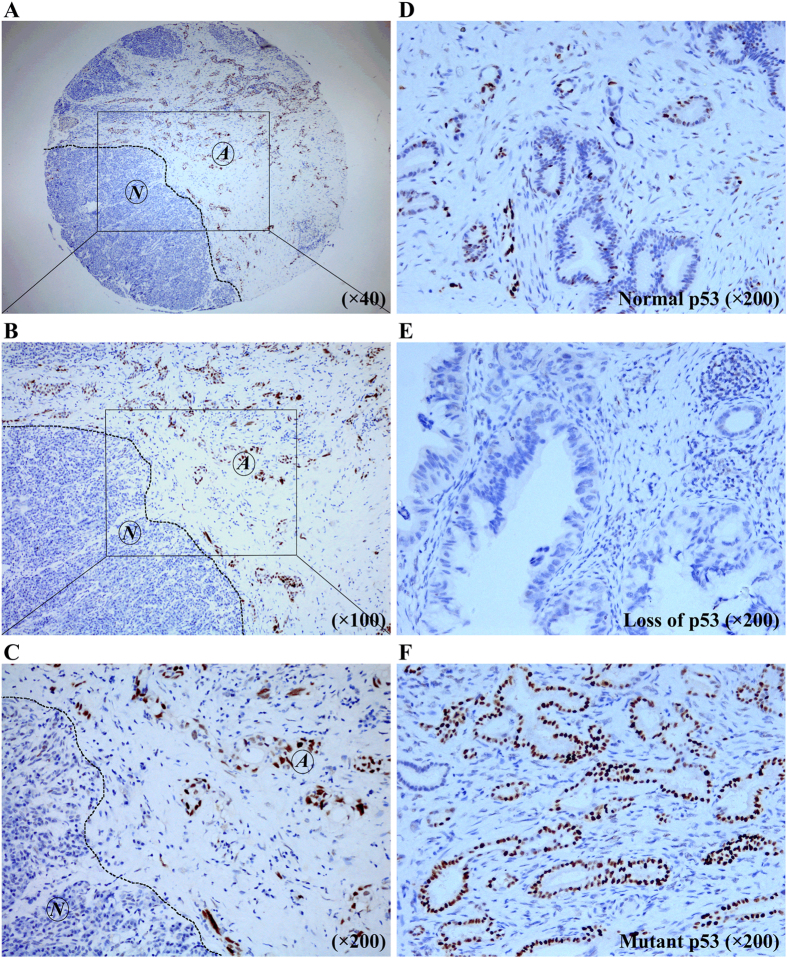
Images from representative specimens with normal and abnormal immunohistochemical labeling profiles of p53 in pancreatic ductal adenocarcinoma (PDAC).(A–C) Sporadic positive nuclear immunolabeling of p53 in ductal and acinar cells of peritumoral normal pancreatic tissue, compared with abnormal expression of p53 in tumor tissue. (D) PDAC tissue with a “normal” pattern of p53 immunolabeling compared with normal pancreatic tissue. (E,F) An abnormal pattern of p53 immunolabeling8, including (E) almost complete loss of p53 expression (nuclear immunolabeling in <5% of neoplastic cells) and (F) overexpression of mutant p53 (diffuse nuclear accumulation of immunolabeled protein in ≥30% of neoplastic cells), in neoplastic cells of PDAC. The original magnification is shown on each image. A, abnormal; N, normal.